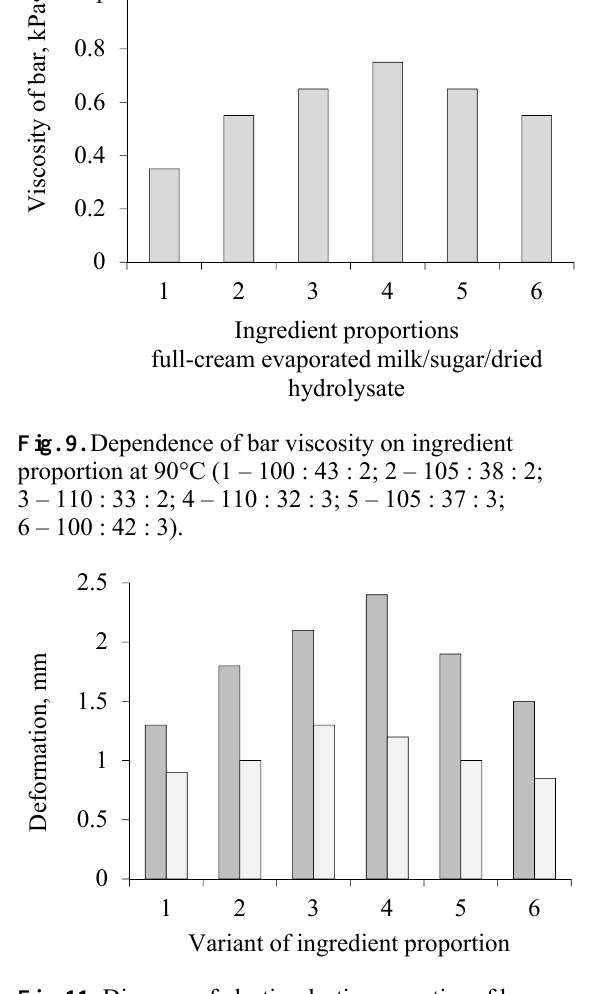
Fig. 11. Diagram of elastic-plastic properties of bar mixture at different ingredient proportions (1 – 100 :